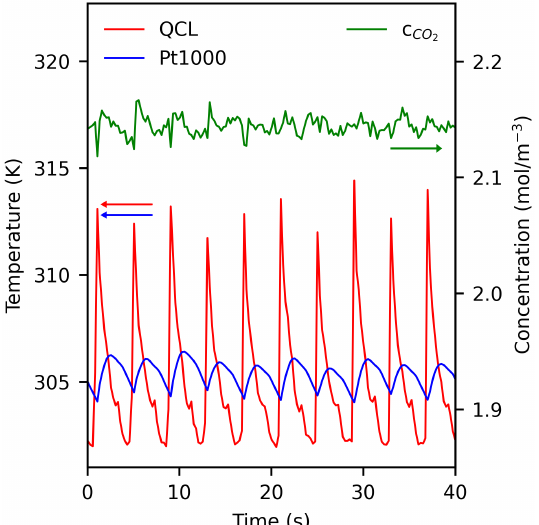
Figure 5. Results from exemplary temperature measurements during breath cycles from an automatic breath simulator. The breath rate was set to 0.25 s − 1 . The calibration curve from the inset of Figure 4 has been applied to the T QCL